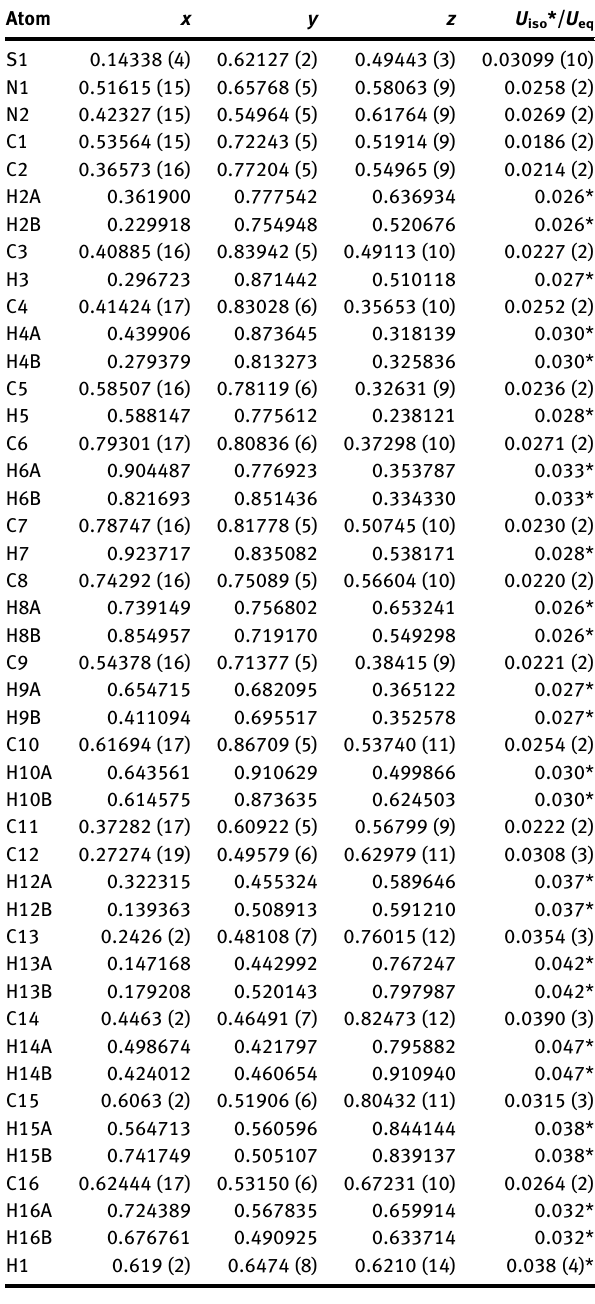
Table  : Fractional atomic coordinates and isotropic or equivalent isotropic displacement parameters (Å 